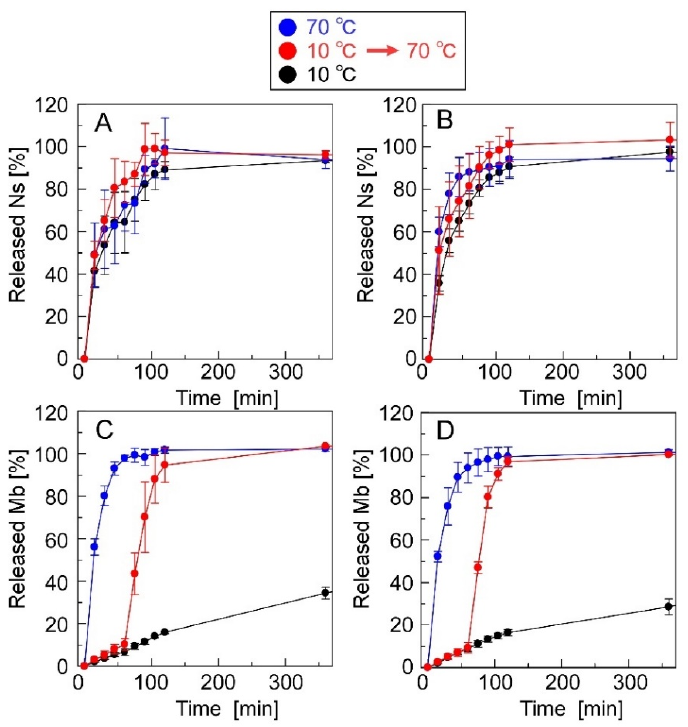
Figure 7. Ns- and Mb-release profiles of the microparticles. The microparticles used were ( A , C ) CRG(CS(Ns), Mb) and ( B , D ) CRG(PLL(Ns), Mb) microparticles. ( A , C ) CRG(CS(Ns), Mb) and ( B , D ) CRG(PLL(Ns), Mb)